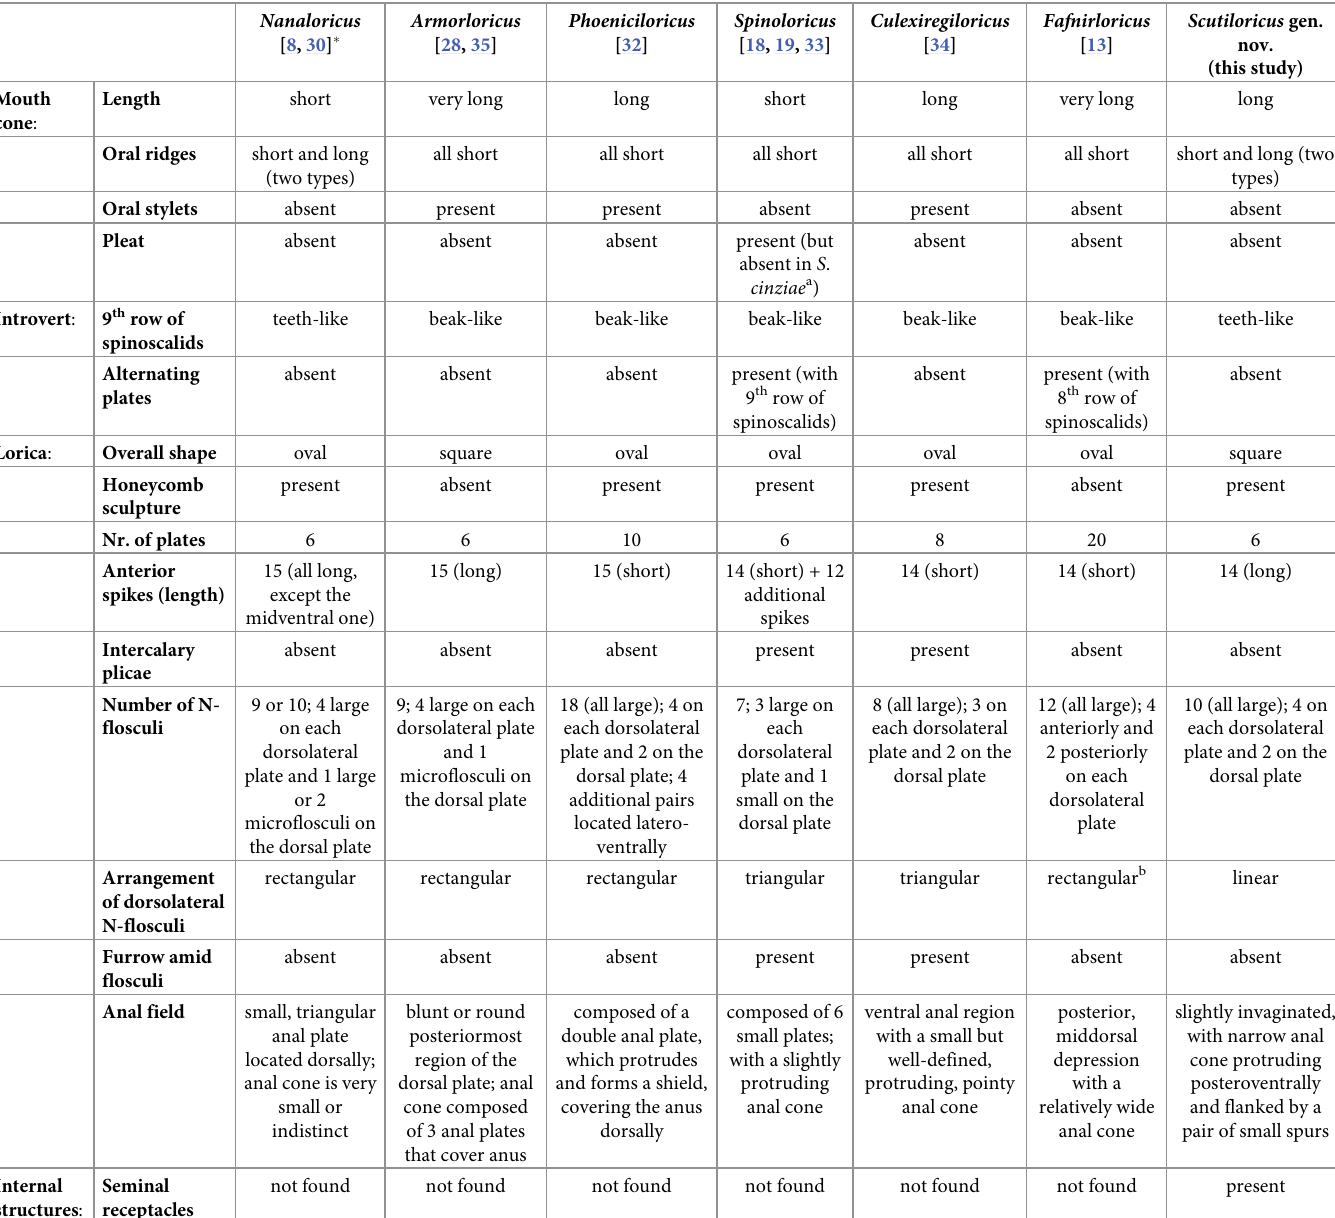
Table 2. Comparison of adult (or in certain cases postlarval) morphological characters between the genera assigned to family